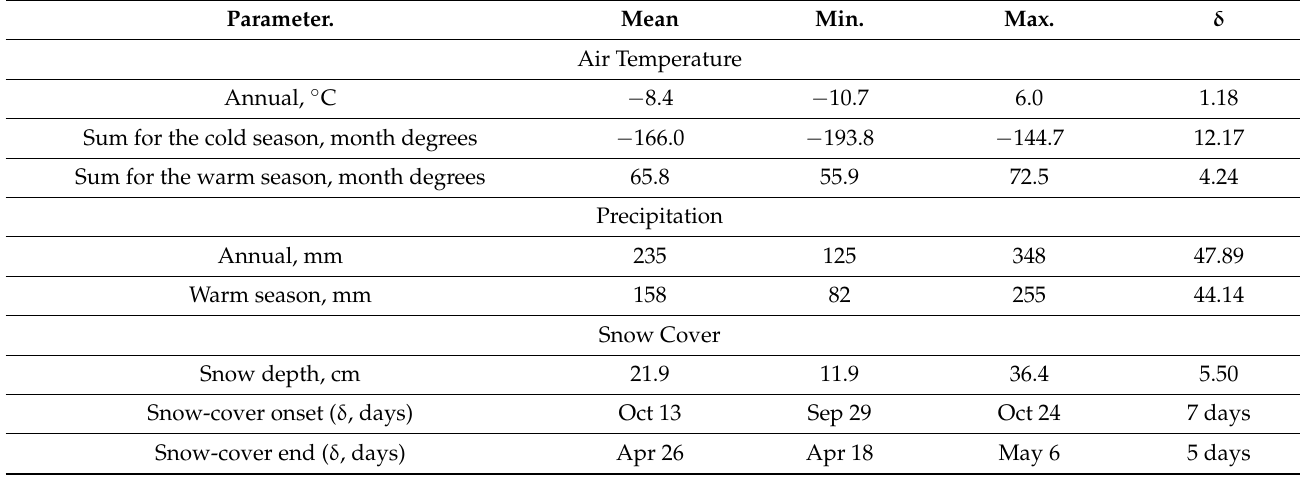
Table 2. Annual and seasonal characteristics of air temperature, precipitation, and snow cover parameters for the period from 1980/81 to 2019/20 (based on Yakutsk station data). Parameter. Mean Min. Max.